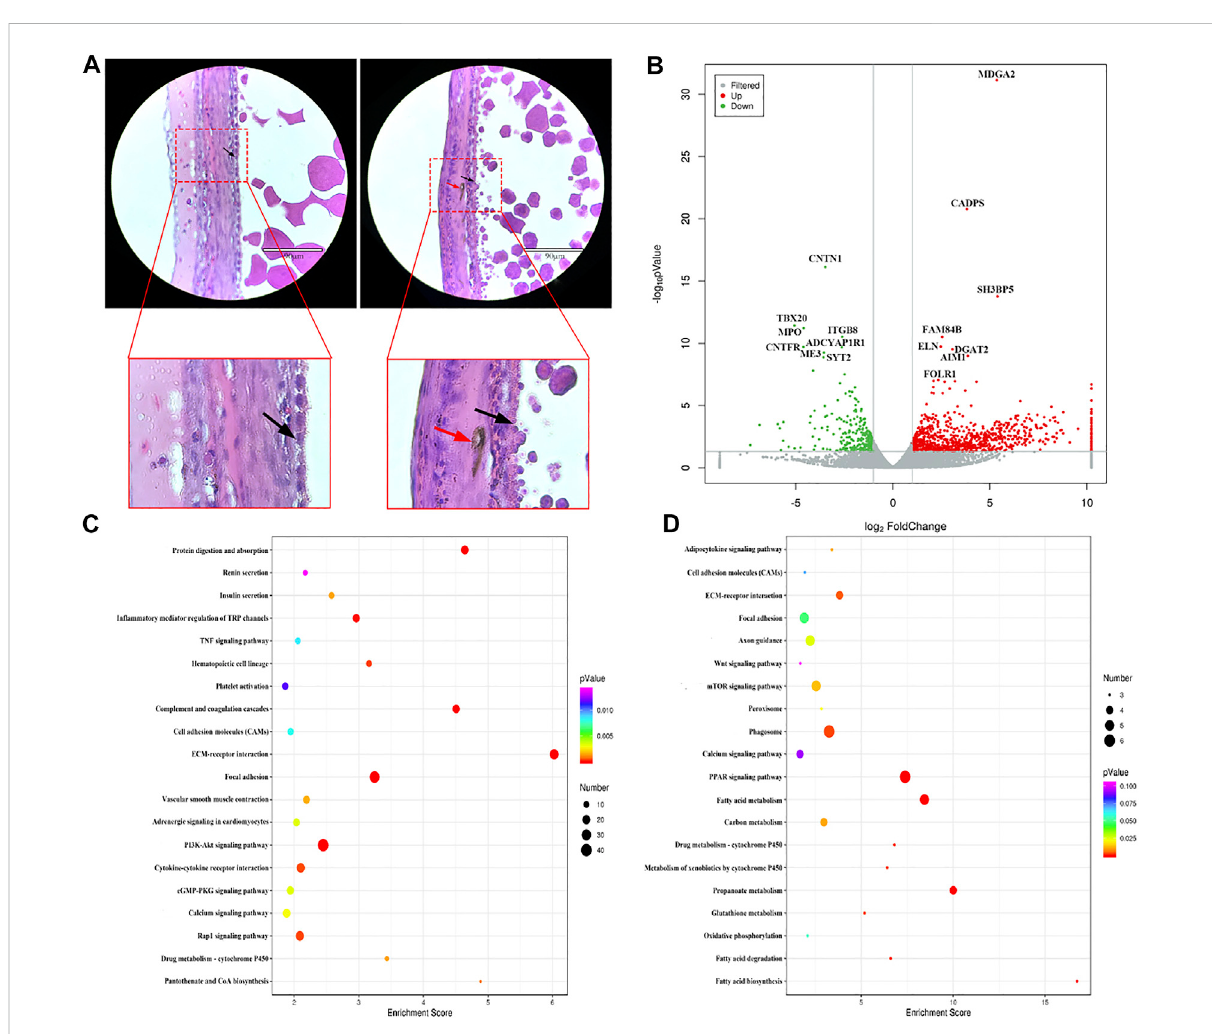
FIGURE 3 Comparison ofgeneexpressiondifferencesbetweenWLandSFpoGCs. (A) HistologicalobservationofWLandSFpoGCs.(LeftisWL,rightisSF. black arrow, follicle granulosa cells; red arrow, melanocytes). (B) Volcano plot of up- and down-regulated genes. (C) Top 20 KEGG pathway of up- regulatedgenesinSFpoGCscomparedwithWLpoGCs. (D) Top20KEGGpathwayofdown-regulatedgenesinSFpoGCscomparedwithWLpoGCs. The x-axis is the enrichment score, the larger the bubble, the greater the number of genes encoding differential proteins. The color of the dots represents the range of q